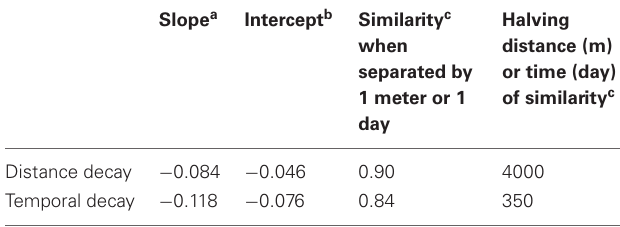
Table 4 | Summary statistics for distance- and temporal-decay relationships fit to our bacterial community similarity data from north temperate lakes.